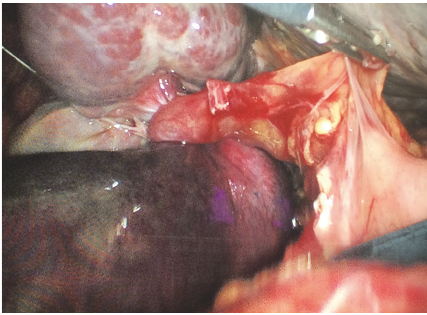
Figure 1: Abdominal contrast enhanced CT scan, portal phase distended gallbladder with focal enhancement defect.